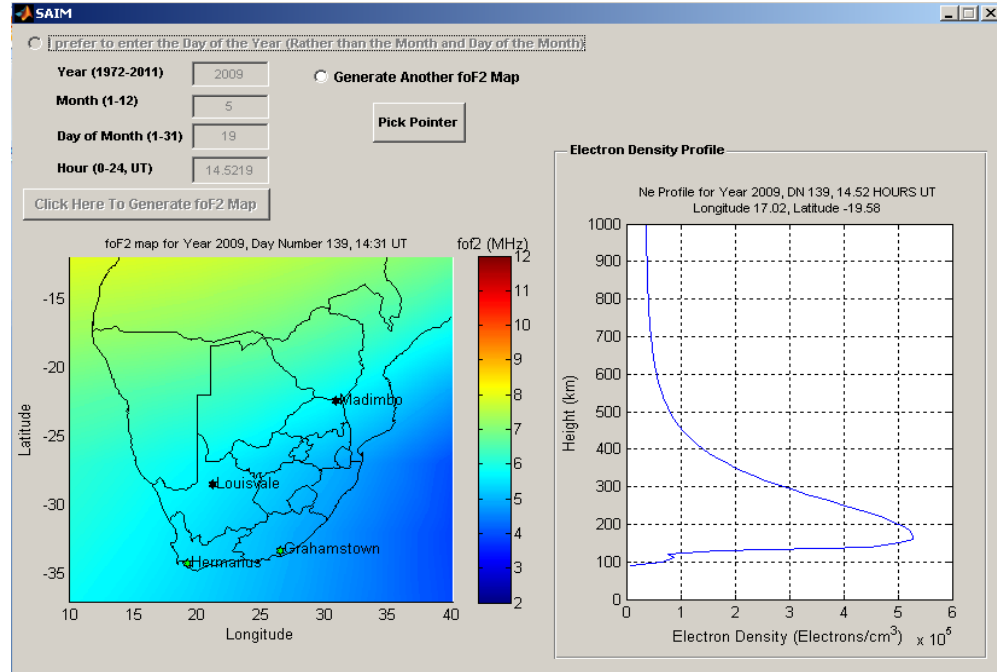
Fig. 2. The Graphical User Interface of the software developed in this work.